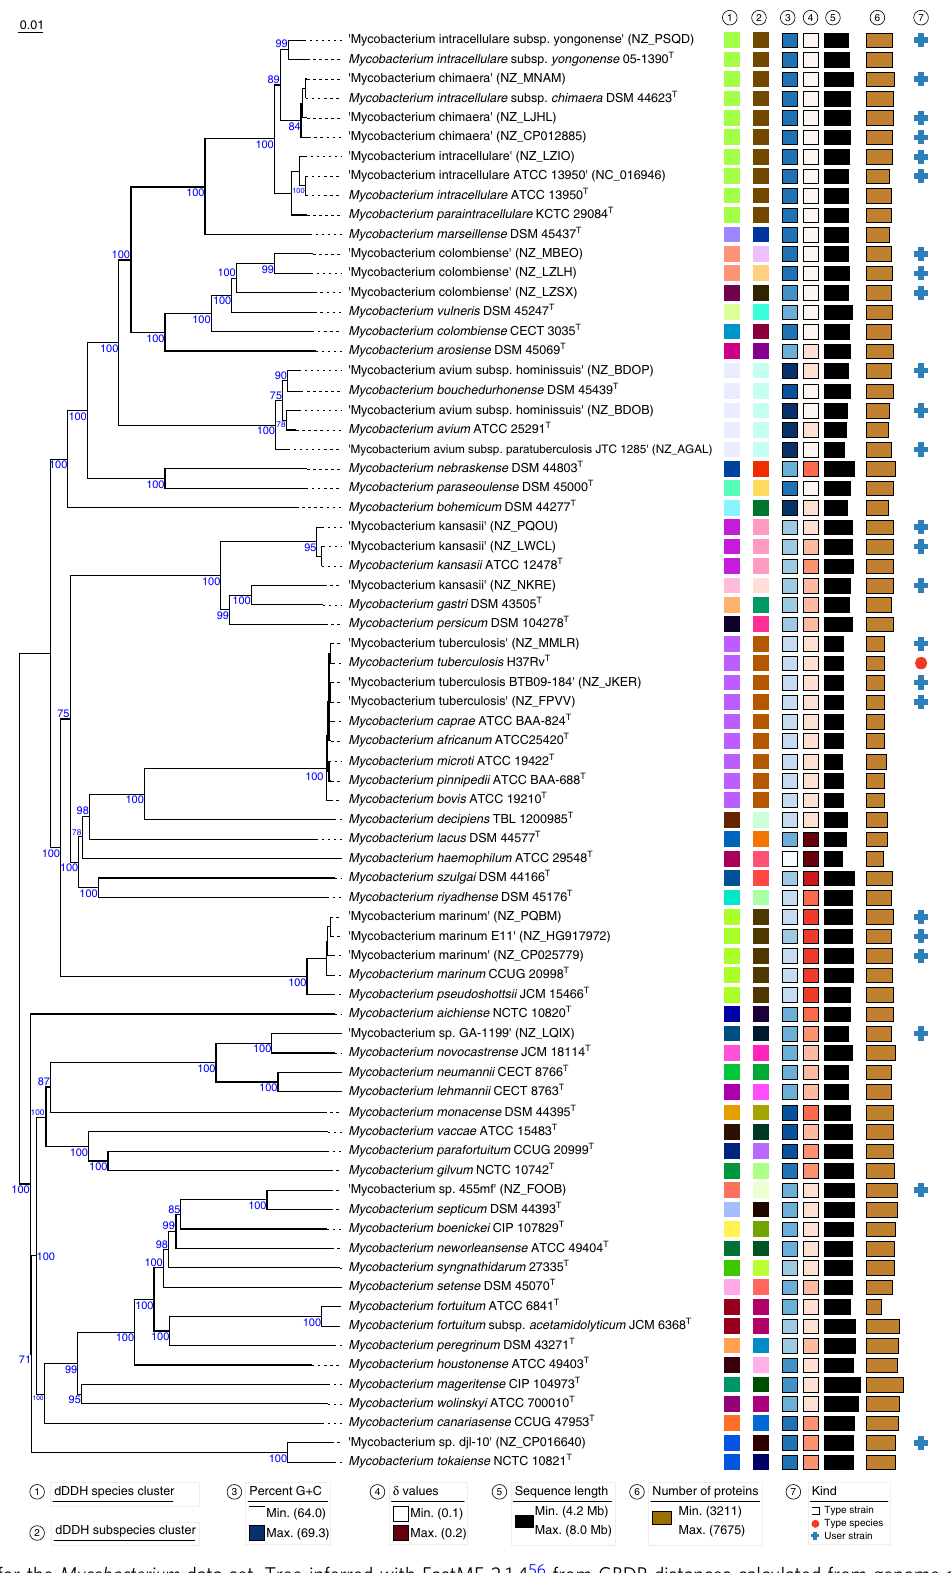
Fig. 2 TYGS result for the Mycobacterium data set. Tree inferred with FastME 2.1.4 56 from GBDP distances calculated from genome sequences. Branch lengths are scaled in terms of GBDP distance formula d 5 ; numbers above branches are GBDP pseudo-bootstrap support values from 100 replications. Leaf labels are annotated by af fi liation to species (1) and subspecies (2) clusters, genomic G + C content (3), δ values (4), overall genome sequence length (5), number of proteins (6), and the kind of strain (7). User-provided GenBank accession IDs are shown in parentheses; master record accessions are